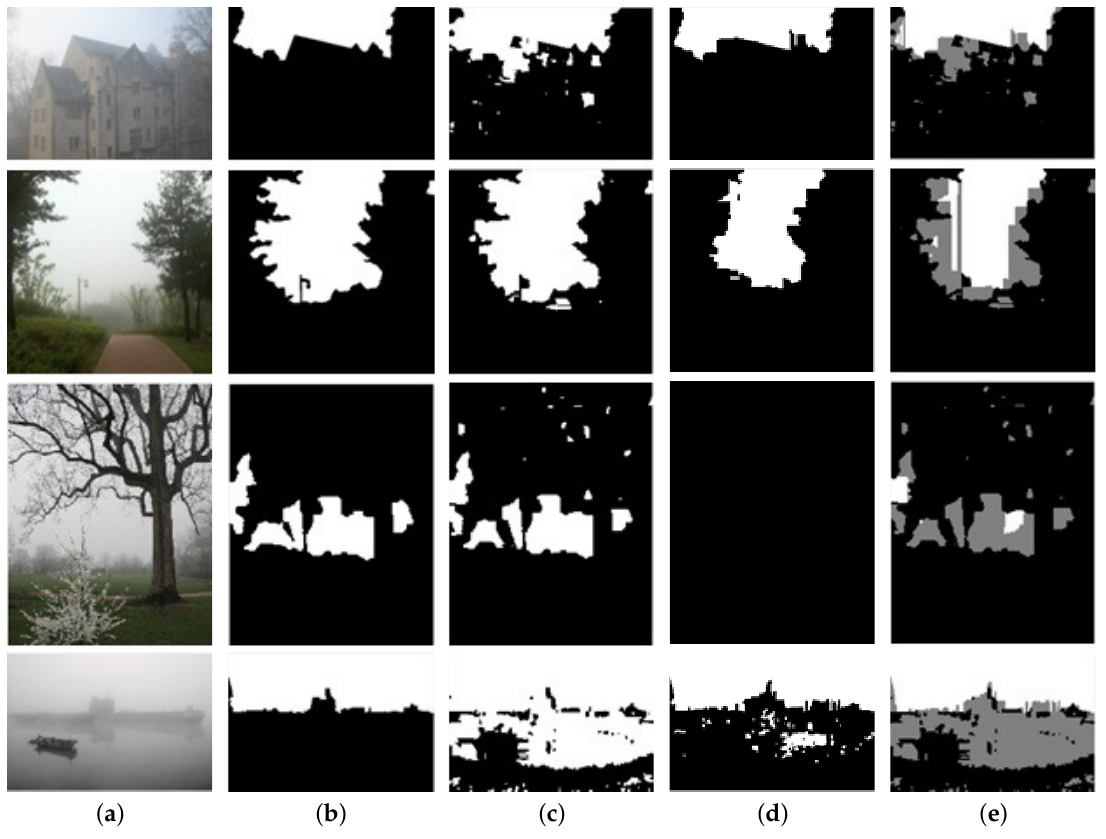
Figure 4. Sky detection results of the first stage. ( a ) Input hazy images; ( b ) ground truth sky; ( c ) classification results of SVM 1 ; ( d ) classification results of SVM 2 ; ( e ) division of the three subregions: white denotes high confidence sky regions; black denotes high confidence non-sky regions; and gray denotes uncertain